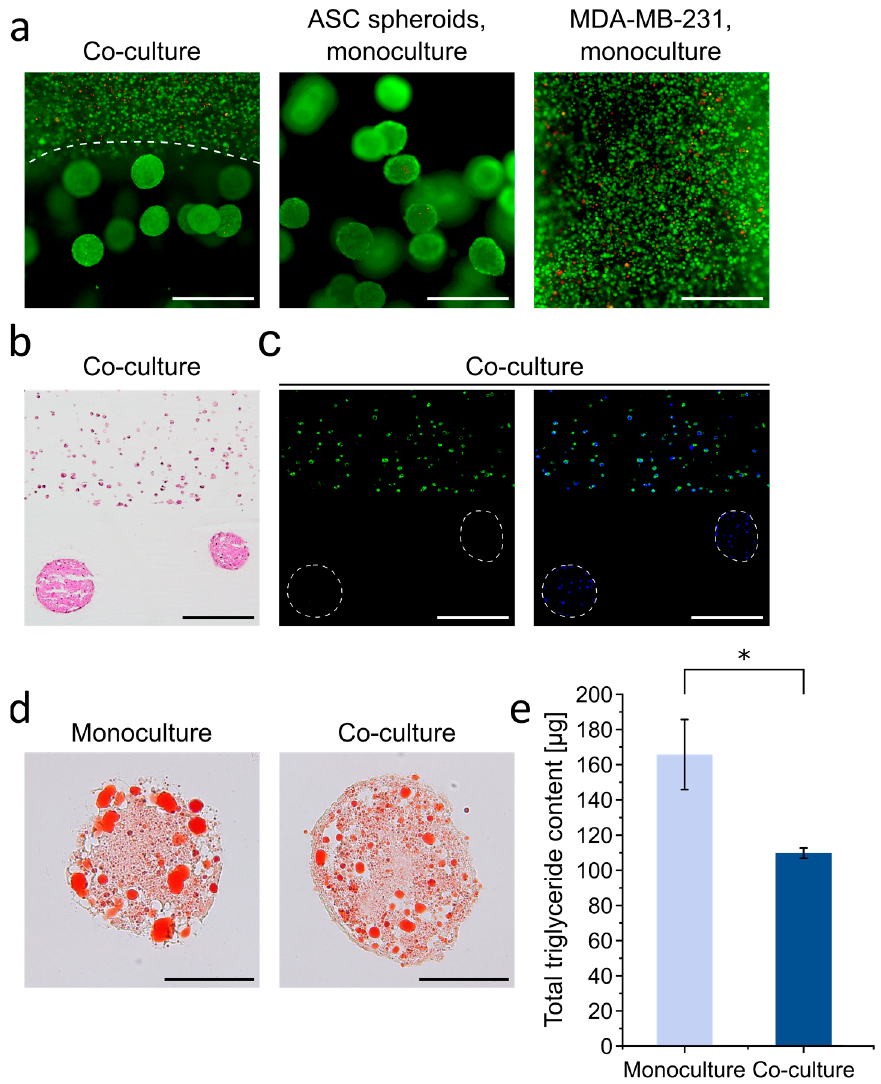
Figure 6. Printed breast cancer-adipose tissue model: viability, cell distribution and lipid content in adipose spheroids. ASC spheroids were printed in HA–SH/P(AGE-co-G) hydrogels, followed by adipogenic differentiation for 21 days. Subsequently, MDA-MB-231 breast cancer cells were printed on the adipose constructs using the same gel formulation, and co-culture was performed for 9 days (i.e., 30 days of total culture time). Constructs with differentiated ASC spheroids or MDA-MB-231 cells in monoculture served as controls. ( a ) Live/dead staining of the printed ASC spheroid/MDA-MB-231 co-culture and the respective monocultures at day 30 of culture (21 days adipogenic differentiation of the ASC spheroid-seeded hydrogels, followed by 9 days co-cultivation with the MDA-MB-231-seeded hydrogels). Living cells are depicted in green (calcein-AM), dead cells are depicted in red (EthD-III). Scale bars represent 500 µ m. ( b ) Histological H&E staining of ASC spheroid/MDA-MB-231 co-culture (day 30, i.e., day 9 of co-cultivation). Scale bar represents 200 µ m. ( c ) Immunohistochemical staining of MDA-MB-231 cells in co-culture using an anti-pan cytokeratin antibody (green, left). Nuclei were counterstained with DAPI (blue, right) (day 30, i.e., day 9 of co-cultivation). Scale bars represent 200 µ m. ( d ) Visualization of accumulated triglycerides by Oil Red O staining of representative ASC spheroids in mono- or co-culture (day 30, i.e., day 9 of co-cultivation). Scale bars represent 100 µ m. ( e ) Quantification of total triglyceride content of ASC spheroids in the ASC spheroid/MDA-MB-231 co-culture compared to monocultured spheroids (day 30, i.e., day 9 of co-cultivation). Data are presented as mean ± standard deviation ( n = 3). Statistically significant differences are indicated by * ( p <